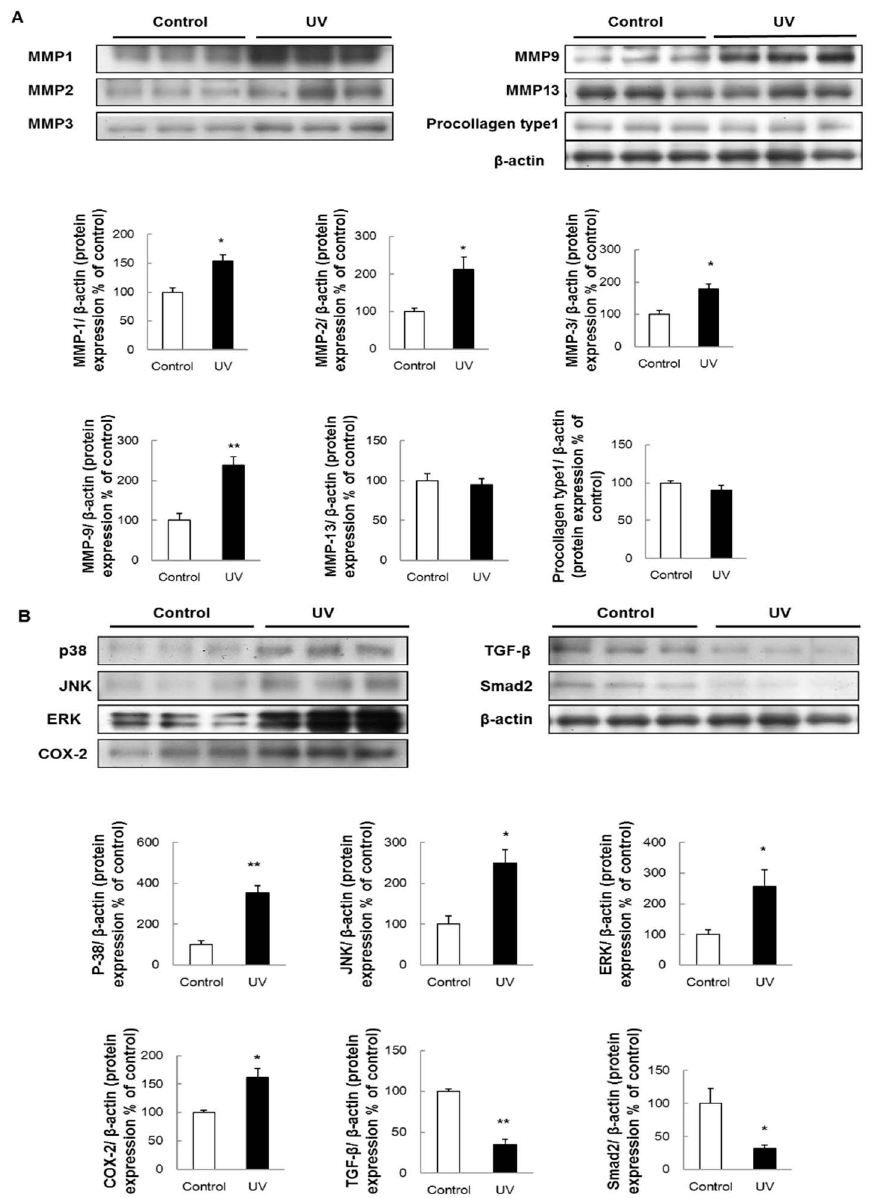
Figure 2. Effects of UV irradiation on the expression of ( A ) Matrix metalloproteinases (MMPs) MMP-1, MMP-2, MMP-3, MMP-9, MMP-13, procollagen type 1, and ( B ) p38, JNK, ERK, COX-2, TGF- β